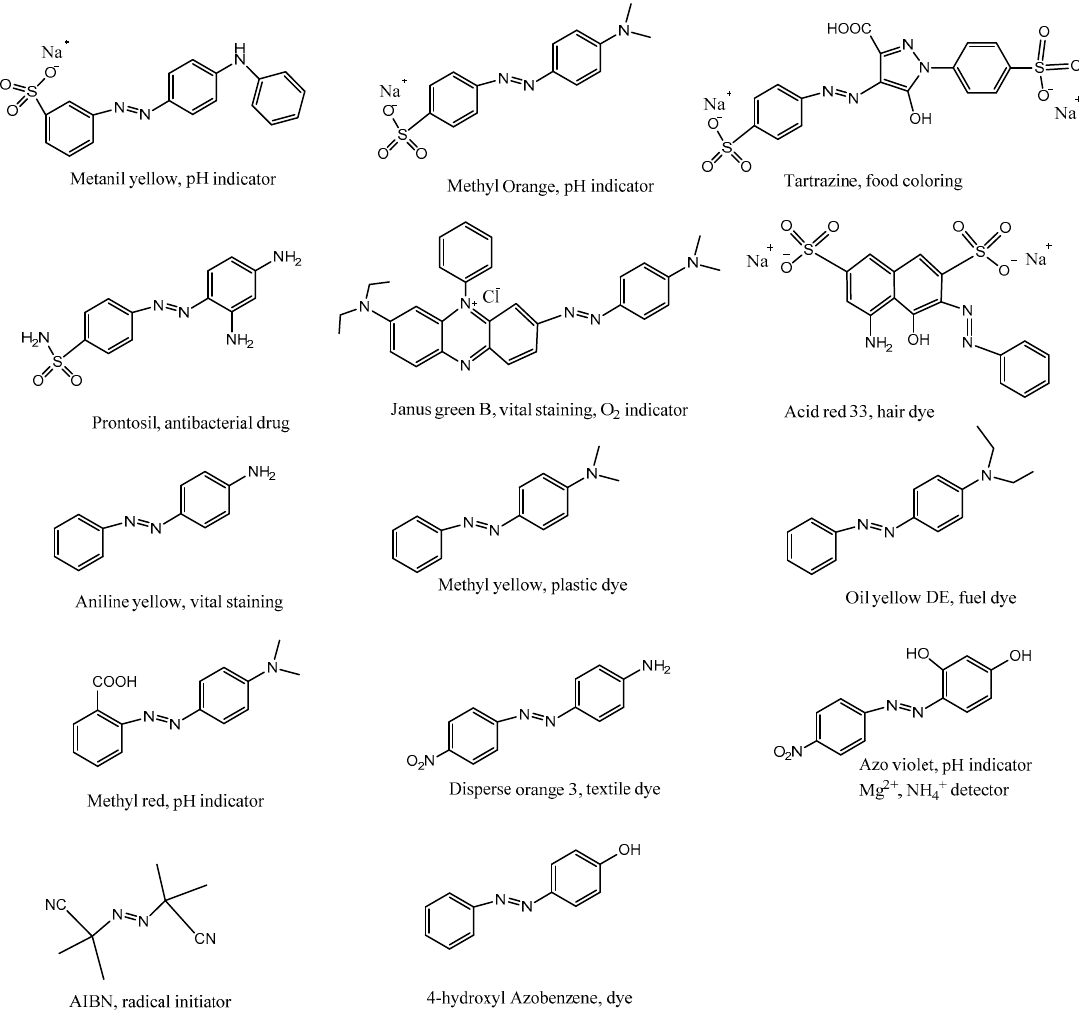
Figure 1. Common azo dyes and their applications.